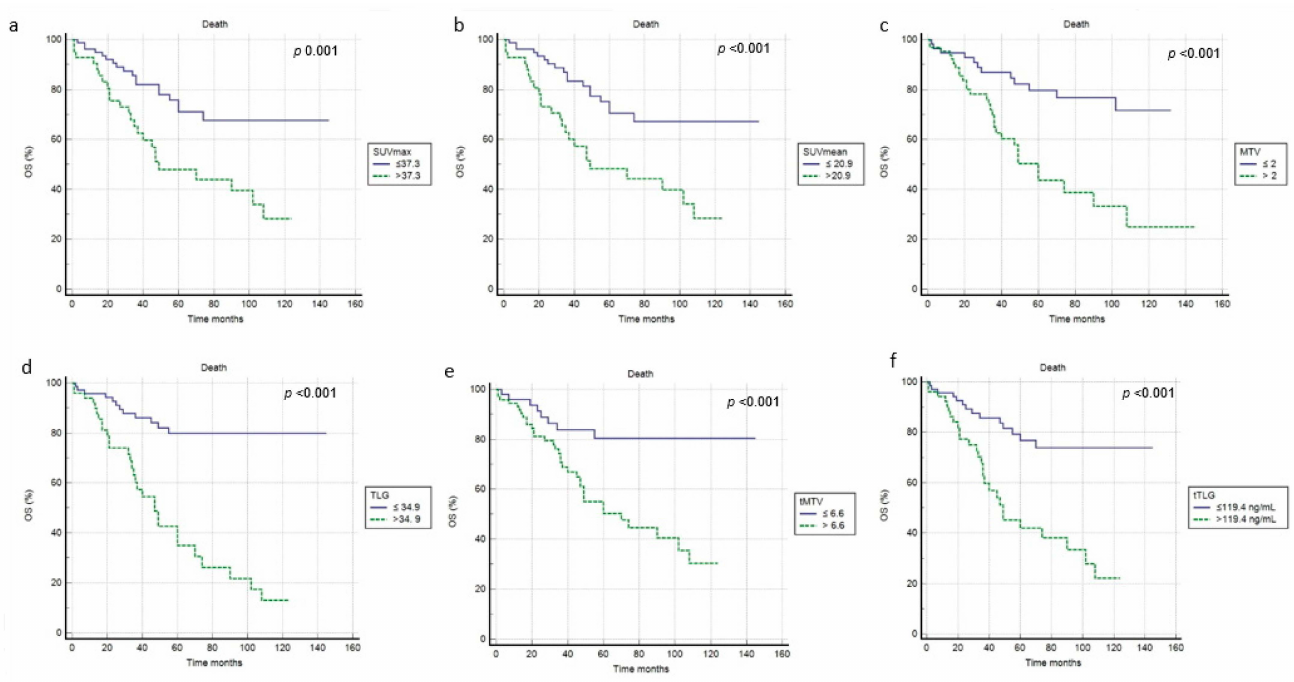
Figure 4. Kaplan–Meier curves relating to OS and the PET/CT metrics (( a ) SUVmax; ( b ) SUVmean; ( c ) MTV; ( d ) TLG; ( e ) tMTV; ( f )